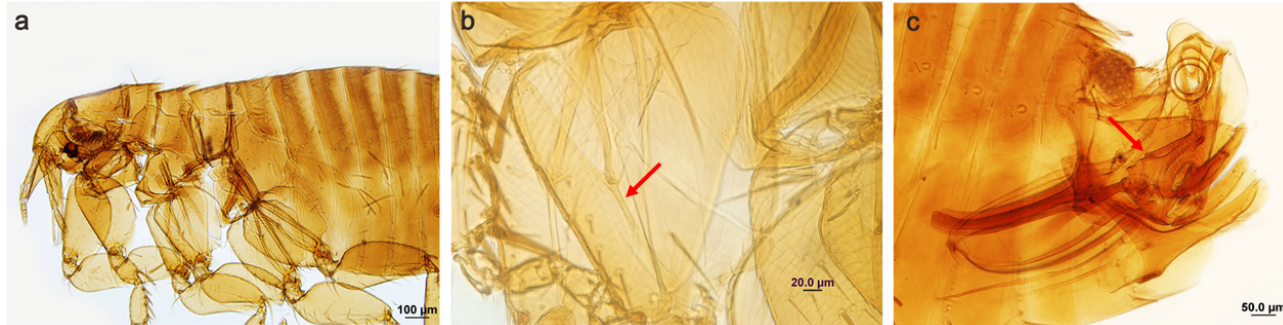
Figure 2. a–c : Polygenis (Polygenis) rimatus : anterior general view ( a ); oblique break of mid coxa (arrow) ( b ); male terminalia, paramere and aedeagus (arrow) ( c ).